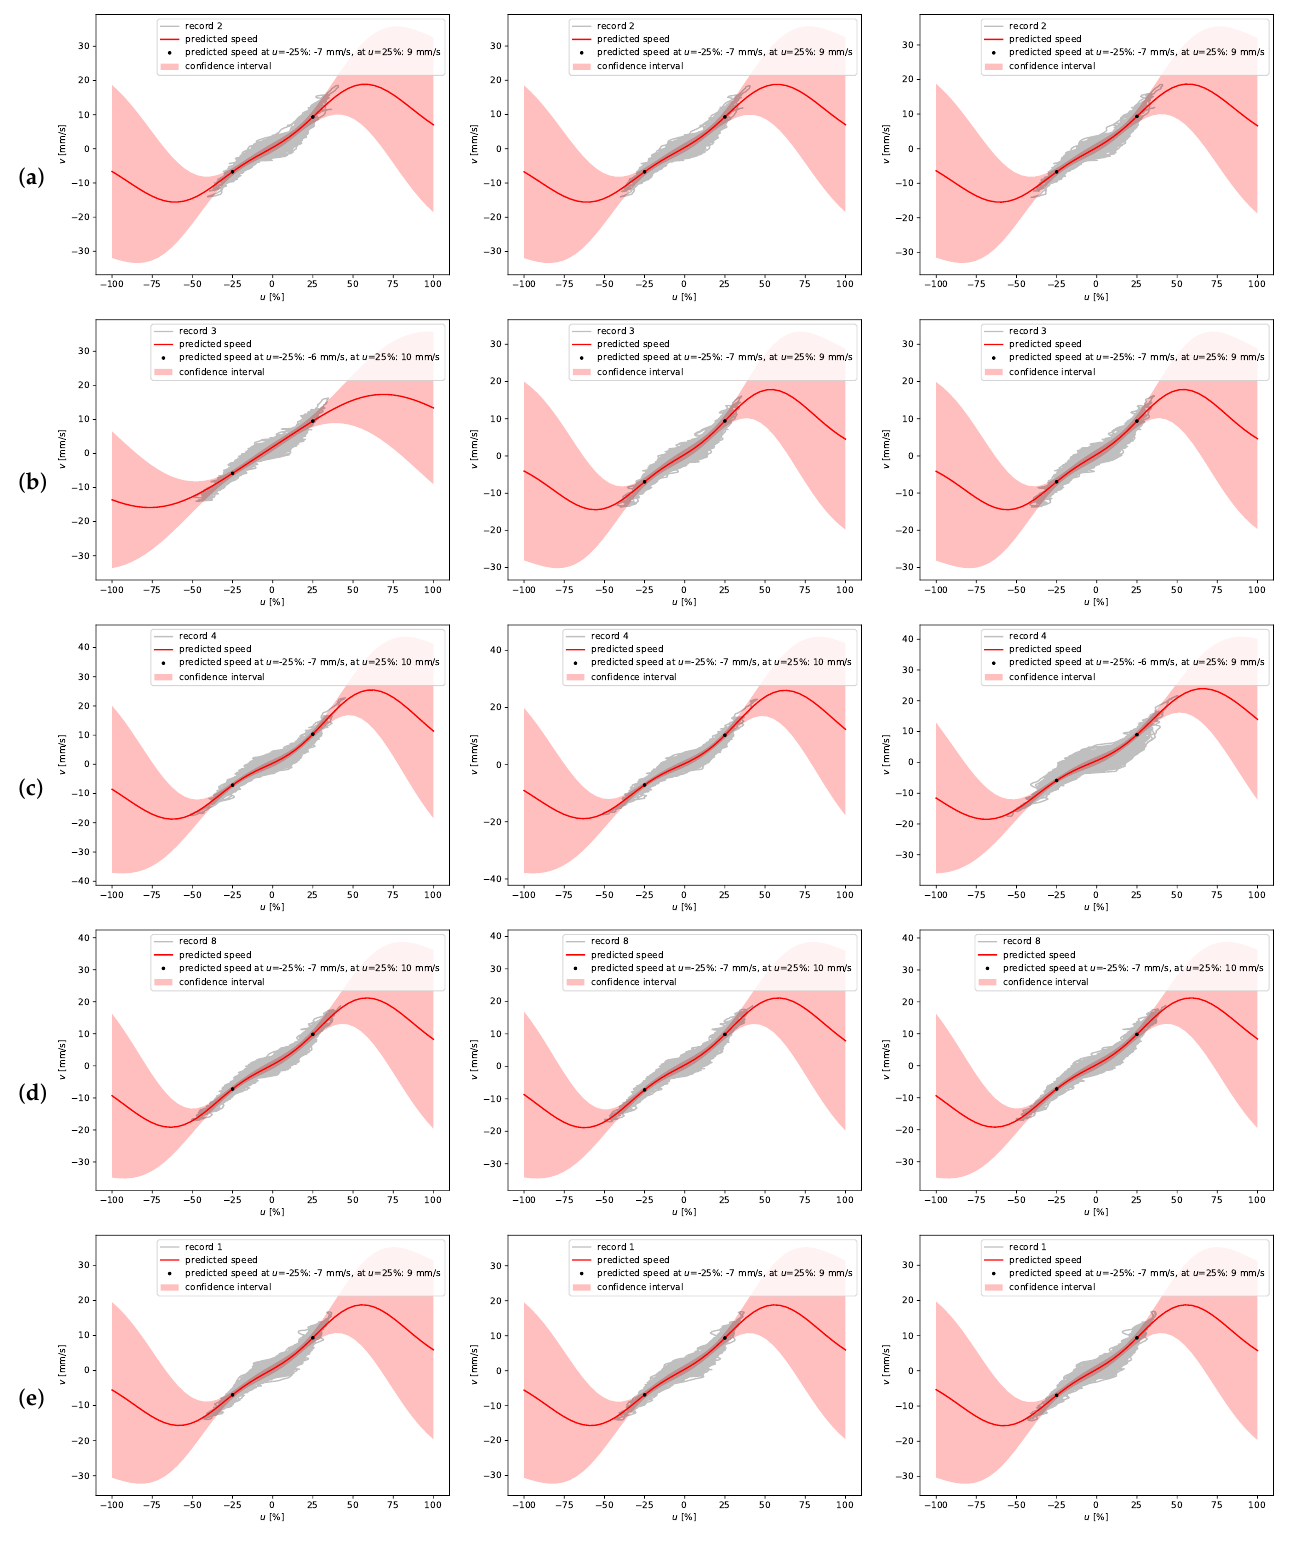
Figure 13. Cylinder velocity prediction with some 10 minute simulations and (a) nominal conditions, (b) a piston seal leak at blade 1, (c) extra friction at blade 3, (d) 50% loss of nitrogen at blade 1 and (e) 6 L/min loss of pump flow.